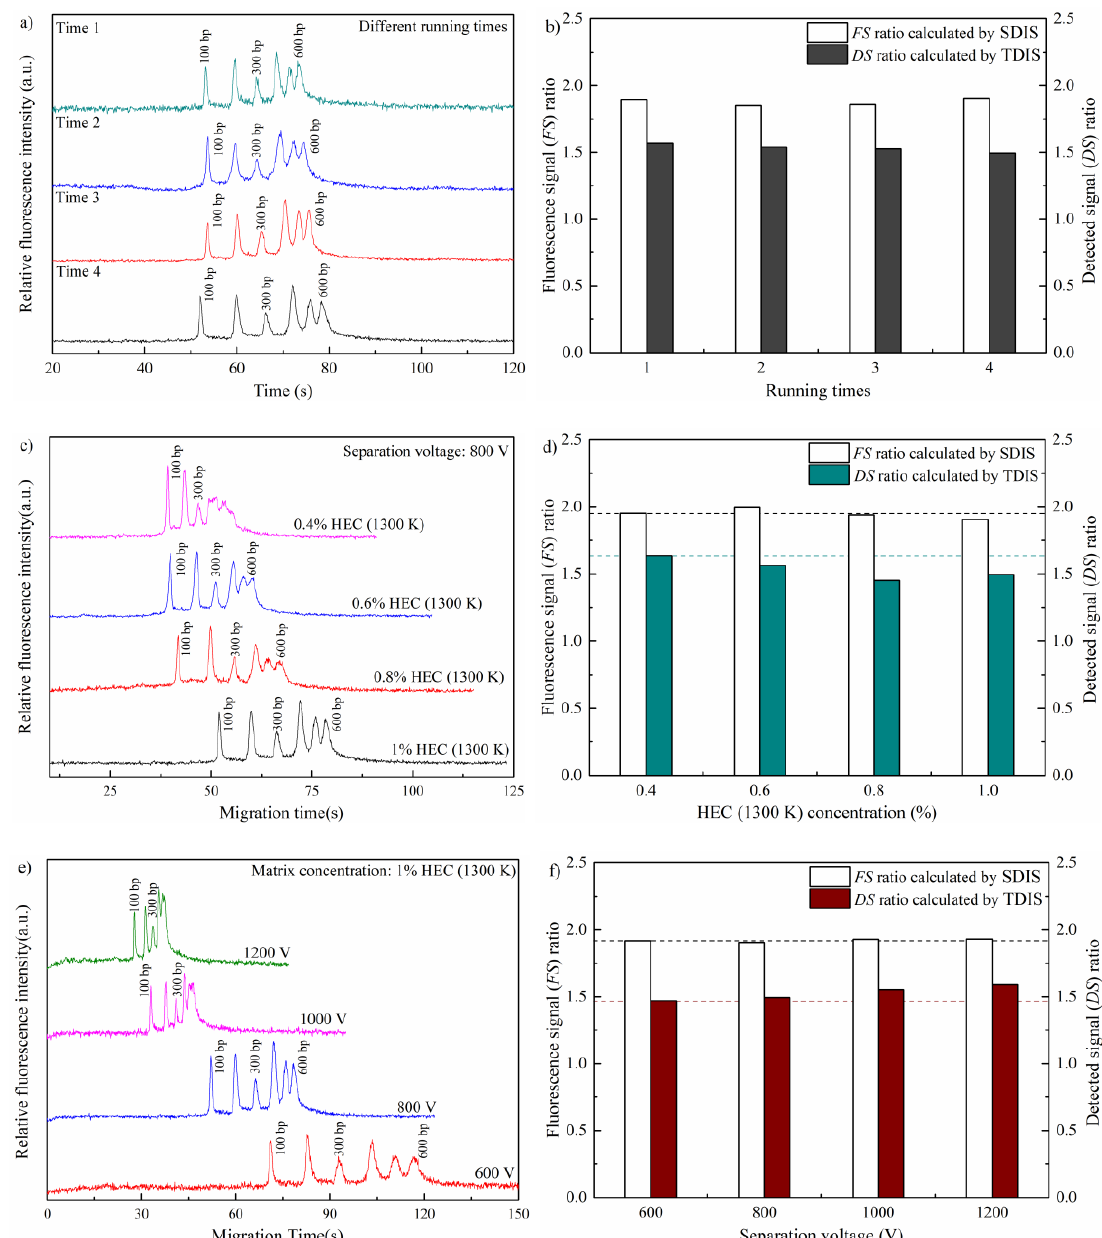
Figure 2. Electrophoretograms of the standard 100 bp ladder marker ranging between 100~600 bp: ( a ) run-to-run tests performed in 1% hydroxyethylcellulose (HEC) (1300 K) at 800 V; ( b ) fluorescence signal ( FS ) and time-domain-detected signal ( DS ) ratios of run-to-run tests; ( c ) HEC (1300 K) matrix concentration ranging 0.4–1%; ( d ) FS and DS ratios of matrix concentrations ranging 0.4–1%; ( e ) separation voltages ranging 600–1200 V; ( f ) FS and DS ratios of separation voltages ranging 600–1200 V. The dash lines in ( d ) and ( f ) were the auxiliary lines for